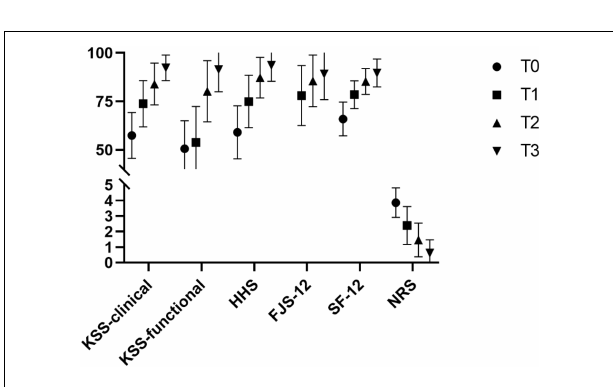
FIGURE 3 | Evaluation index results before and after